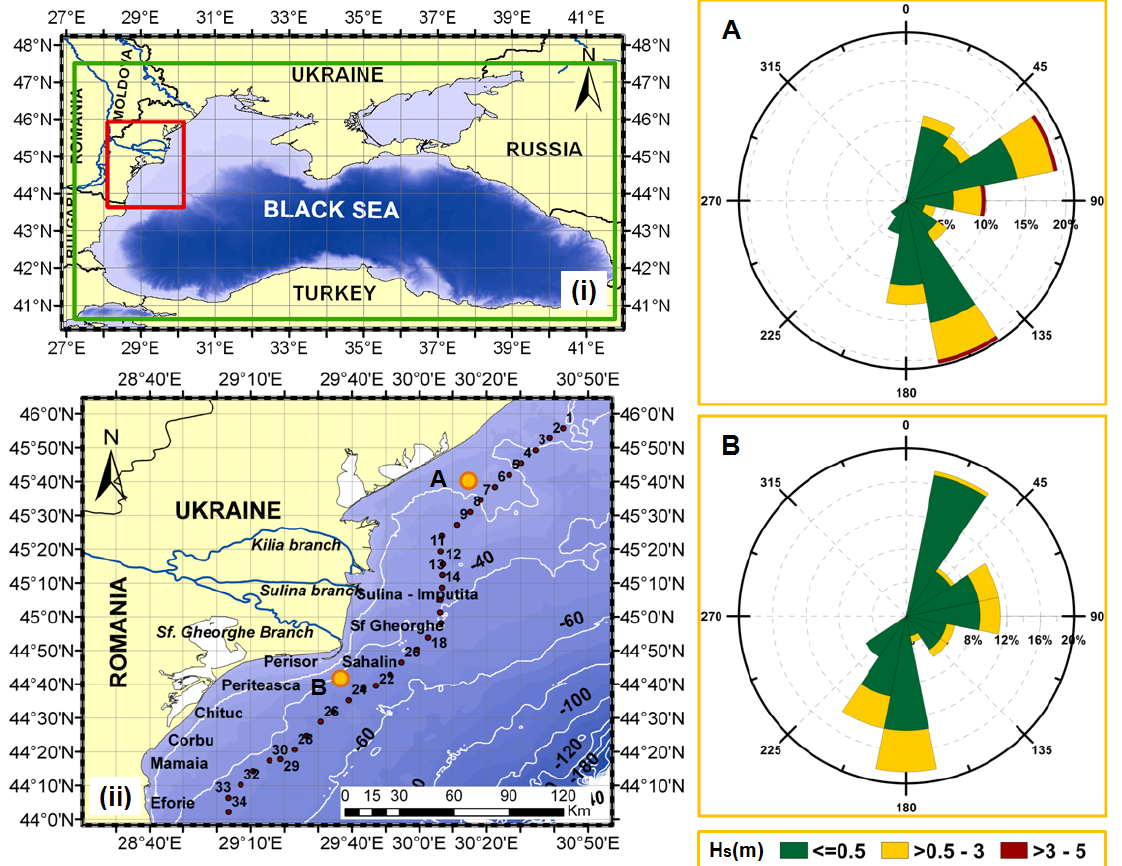
Figure 1. ( i ) Map of the Black Sea. The computational domain for the Simulating WAves Nearshore (SWAN) model is enclosed by a green rectangle (see first step of the proposed methodology), whereas the northwestern Black Sea is enclosed by a red rectangle (see the second step of the same methodology). ( ii ) Map of the northwestern Black Sea. Nodes from the statistical model are in red and are numbered from north to south. The right figure shows wave-roses at points A and B (orange dots) from the map of the northwestern Black Sea [29]. The bar on the right-bottom shows the wave height-ranges at the